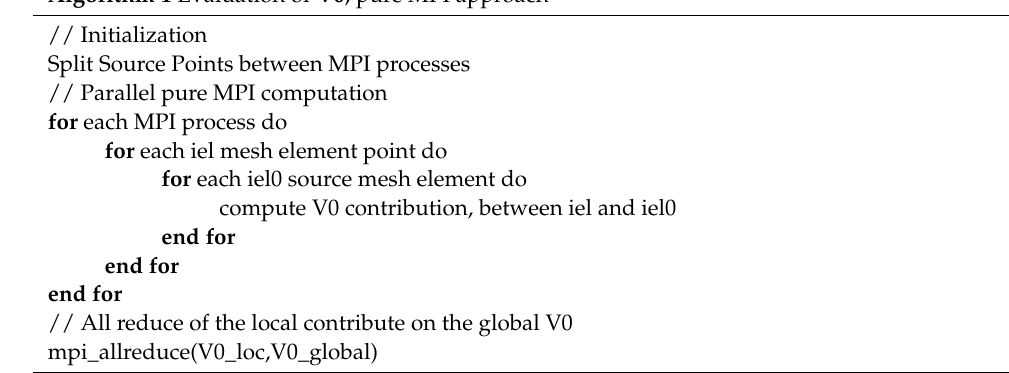
Algorithm 1 Evaluation of V0 , pure MPI